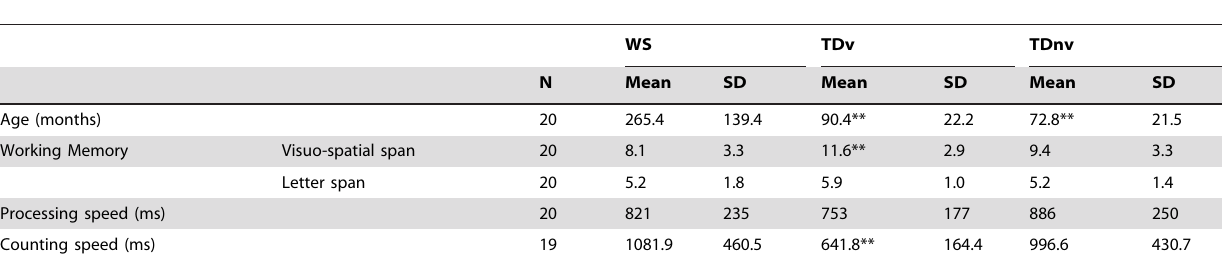
Table 2. Mean Chronological Age and Mean Performance in Working Memory, Processing Speed and Counting Speed by Group.